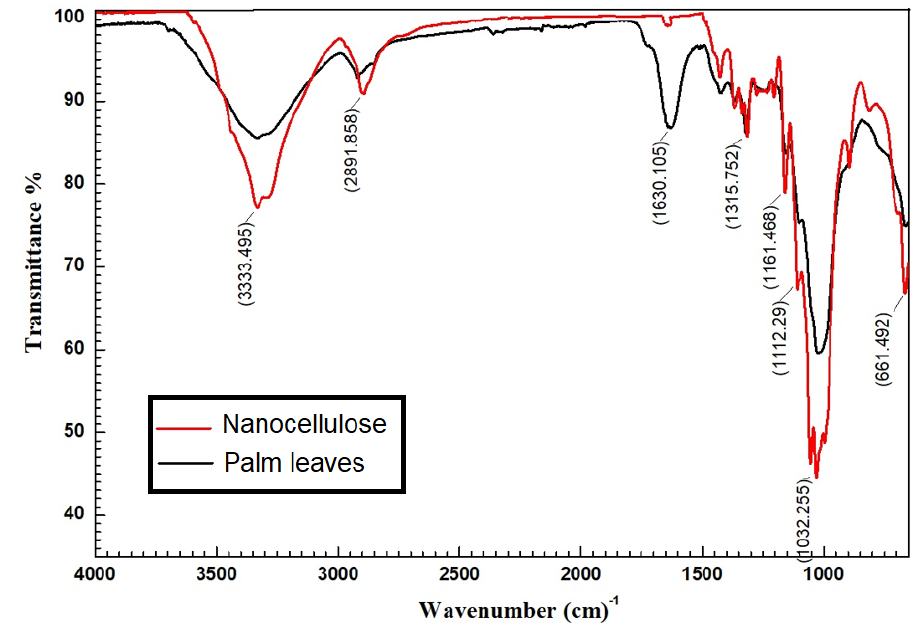
Figure 8. FTIR analysis of cellulose and palm leaves.